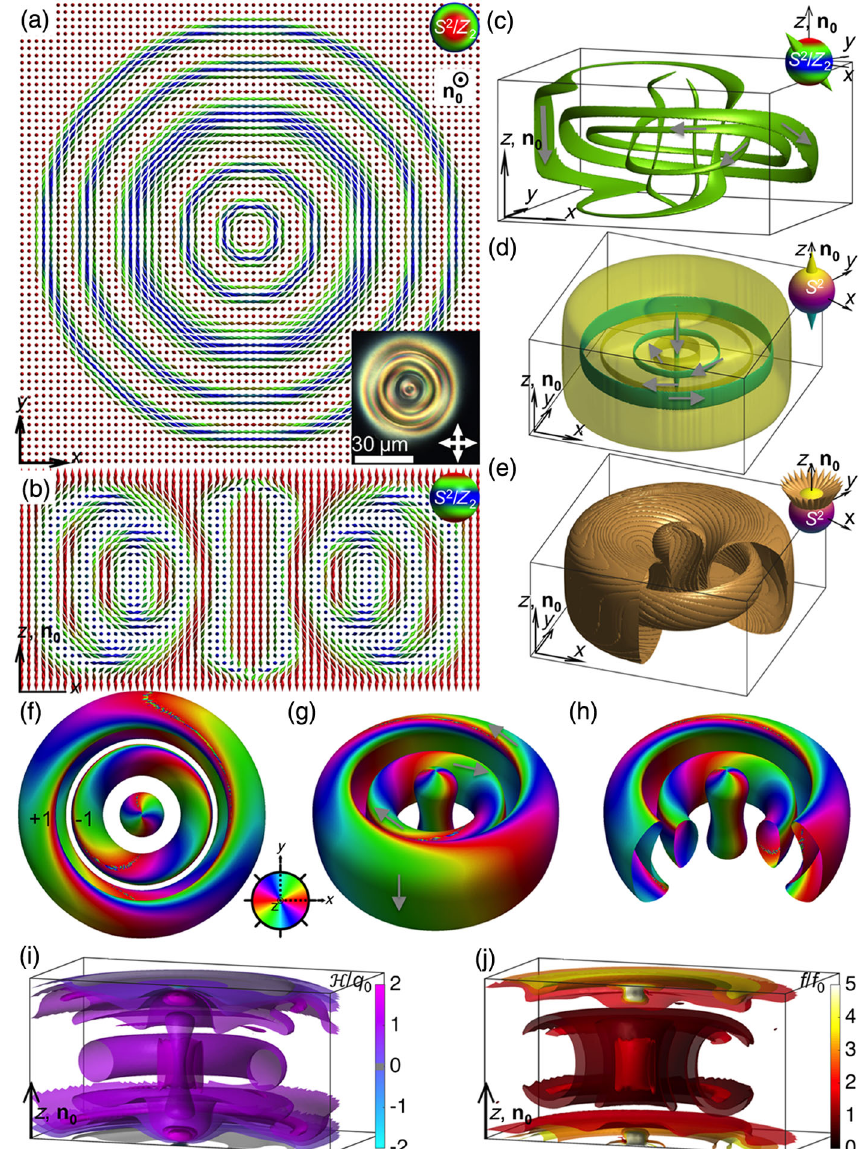
FIG. 12. Toron with complex linking and 5 π twist from its central axis to the far-field periphery. (a), (b) Computer-simulated (a) in- plane and (b) vertical cross sections of the axially symmetric n ð r Þ structure of the toron depicted using double cones and the color scheme that establishes correspondence between director orientations and the points on S 2 =Z 2 (top right insets). The two small regions of discontinuity in orientation of the double cones are the hyperbolic point defects. The inset in (a) shows a polarizing optical micrograph of such a structure. The optical micrograph is obtained for a 5CB-based partially polymerizable LC in a cell of d ¼ 10 μ m. (c) A representative computer-simulated preimage of the hopfion for the diametrically opposite points on S 2 =Z 2 marked by double cones in the top right inset. The preimage is composed of four interlinked closed loops and two half-loop bands terminating on the point defects. (d), (e) Computer-simulated preimages of the toron in a vectorized n ð r Þ (d) for two diametrically opposite points on S 2 corresponding to its north and south poles (top right inset) and (e) for a set of points characterized by a constant polar angle θ and forming a circle parallel to the sphere ’ s equator (top right inset). Note that the closed-loop preimages in (e) reside on two nested tori surfaces while half-loop bands form another surface spanning between the point defects. A large variety of preimages of this solitonic configuration are shown in Video 4. (f) – (h) Three representative views on the isosurfaces of θ ¼ π = 2 ( n z ¼ 0 ) colored by azimuthal orientations of n ð r Þ according to the scheme shown in the right-had side inset of (f). The numbers on top of the tori shown in (f) indicate the linking numbers that characterize the interlinking of colored closed-loop bands and preimages of n ð r Þ corresponding to points on the equator of S 2 =Z 2 . Gray arrows in (c) and (d) and on the green bands of (g) indicate the consistently determined circulations of the preimages. (i),(j) Perspective views of the 3D computer-simulated isosurfaces of normalized (i) handedness and (j) free-energy density for this axially symmetric 3D soliton, with the corresponding color schemes shown in the right-hand side insets. Computer simulations are performed for elastic constants of ZLI-2806 and d=p ¼ 2